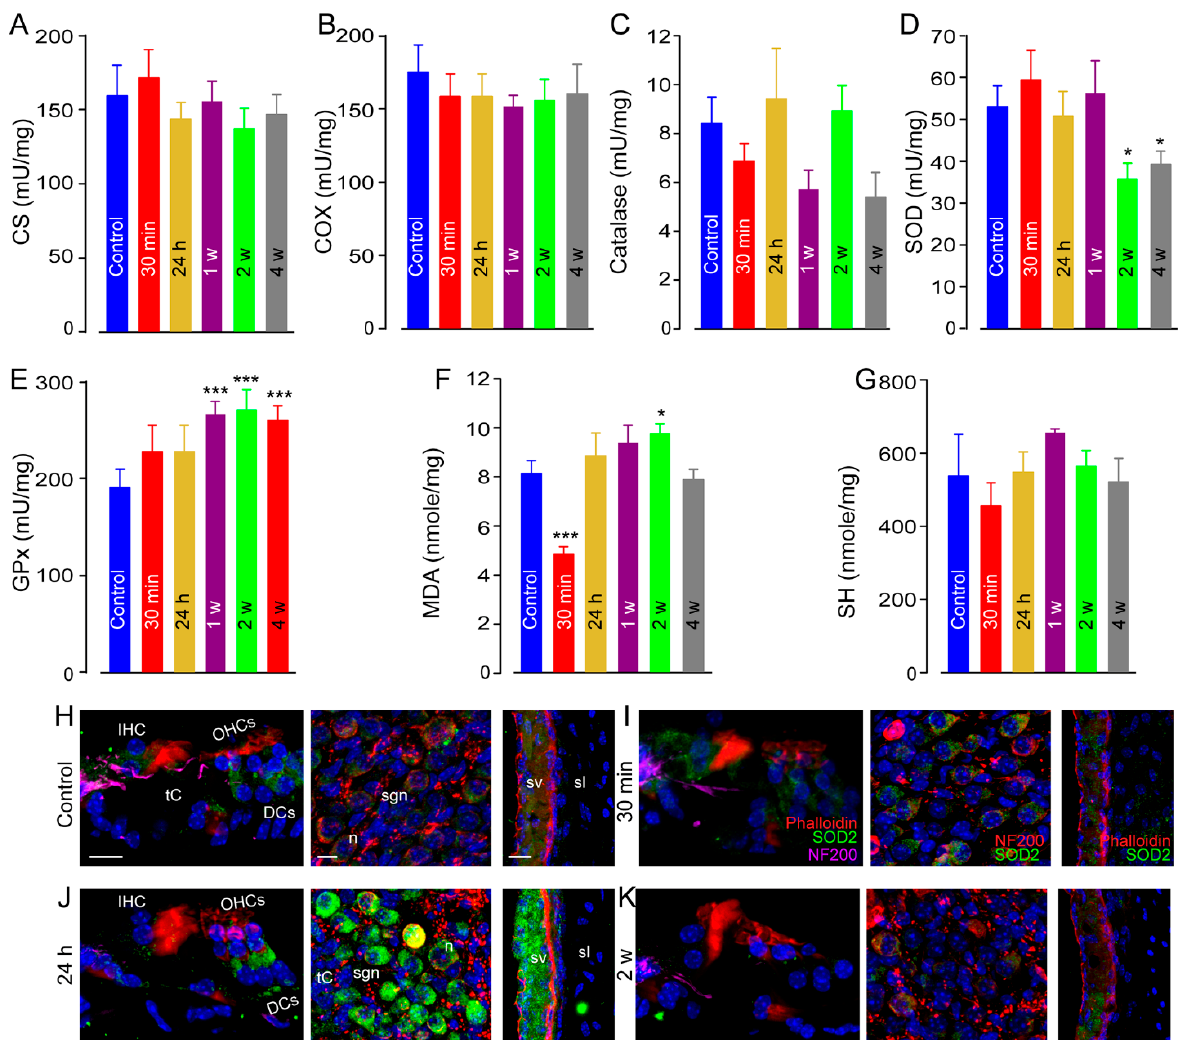
Figure 6. Oxidative stress. ( A – G ): Quantitative analysis of citrate synthase (CS), ( A ), cytochrome c oxidase (COX), ( B ), catalase ( C ), superoxide dismutase (SOD), ( D ), and Glutathione peroxidase (GPx), ( E ) activities, and the levels of malondialdehyde (MDA), ( F ) and thiols (SH), ( G ) using spectrofluorochemistry in whole cochlear extracts from control and impulse-noise-exposed cochleae at the different times after exposure ( n = 16 cochleae per condition). All data are expressed as mean ± SEM, one-way ANOVA test was followed by Dunn’s test. * p ≤ 0.05, *** p ≤ 0.001, vs. control. ( H – K ): Confocal images of transverse cryostat sections of the organ of Corti (left columns), SGNs (mid columns) and stria vascularis (right columns) from the cochleae of control ( H ) and impulse noise-exposed mice at 30 min ( I ), 24 h ( J ), and 2 weeks ( K ) after. Sections were immunolabeled with antibodies against SOD2 (green), and NF 200 (red in mid columns). Phalloidin rhodamine and DAPI were used to label actin and nuclei, respectively. Note that SOD2 immunoreactivity is increased at 24 h after, and reduced at 2 weeks after, exposure, mainly in OHCs, Deiters’ cells (DCs), SGNs, and stria vascularis. tC: tunnel of Corti, sgn: spiral ganglion neuron, sv: stria vascularis, sl: spiral ligament. Scale bars =15 µ